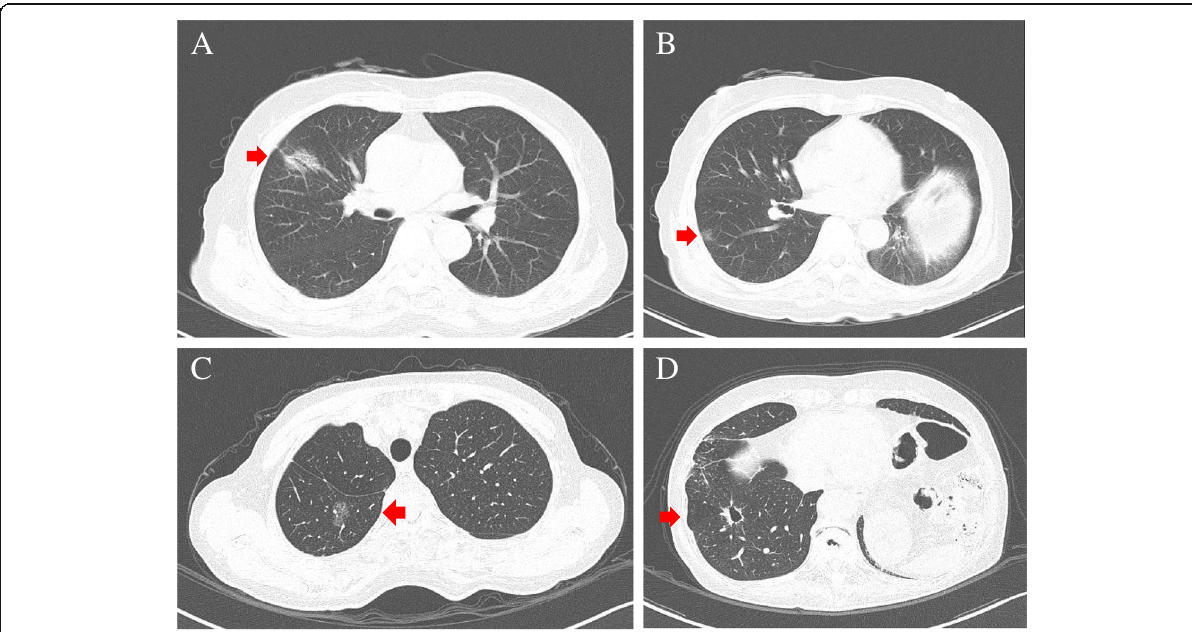
Fig. 1 Chest CT showing multiple lung tumors. a Right S 2 tumor. The size was 28 mm. b Right S 6 b peripheral tumor. The size was 10 mm. c Right S 6 a pure ground-glass nodule. The size was 27 mm. d Right S 9 solid tumor near a bulla. The size was 21 mm